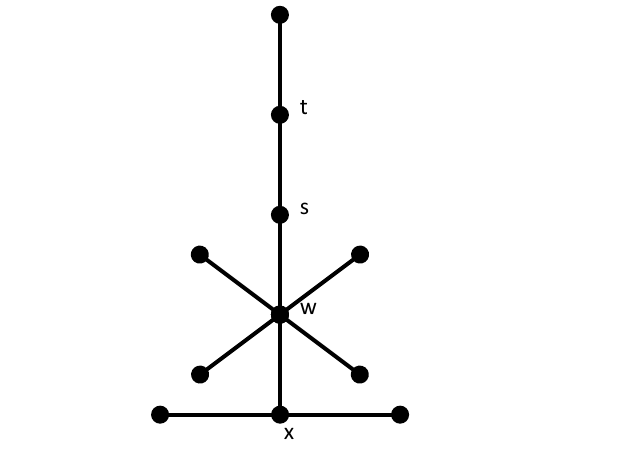
Figure 16: A trunk vertex 𝑥 adjacent to vertex 𝑤 which is not a near